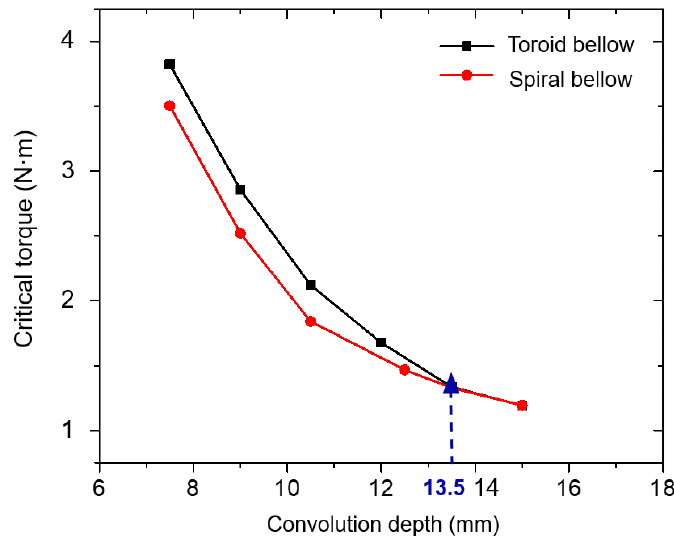
Figure 13. Curve of critical torque versus convolution depth.